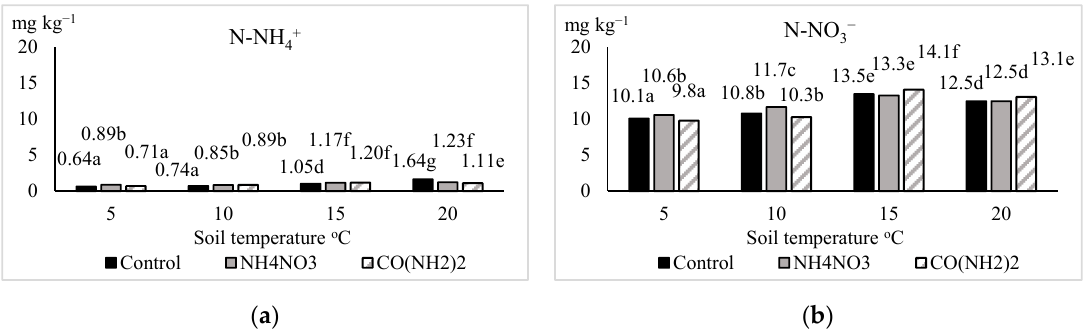
Figure 2. The influence of nitrogen fertilizers and ambient temperature on the changes of ( a ) N-NH 4+ and ( b ) N-NO 3 − in the 15–30 cm soil layer with a simulated precipitation amount of 10 mm. Values followed by different letters are significantly different ( p ≤ 0.05) based on Fisher’s LSD test.